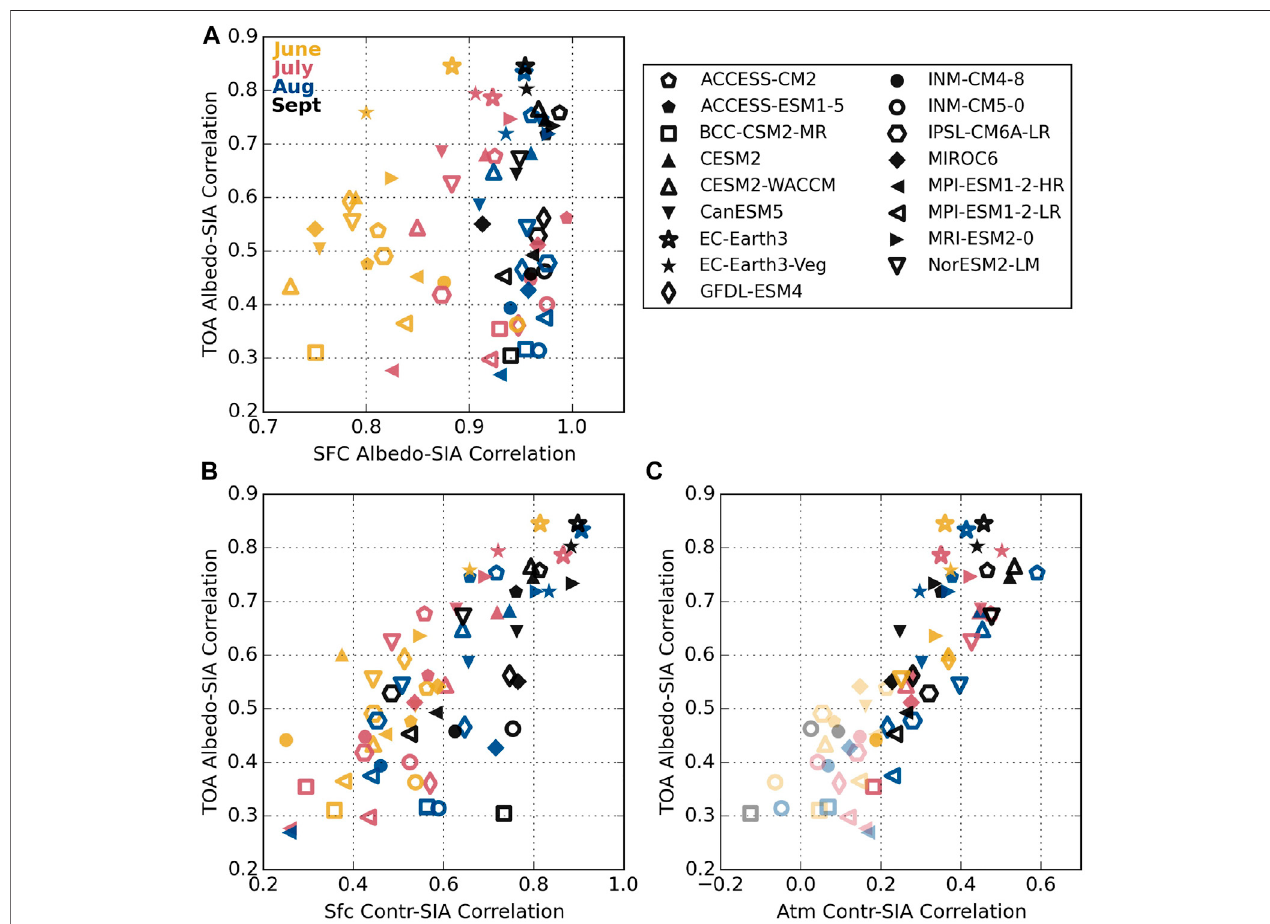
FIGURE 4 | Correlations between albedos and SIA as they relate to each other during summer months. Correlation coef fi cients are calculated over the historical period,1900 – 2014,usingdetrendedanomalies.Correlationcoef fi cientsthatareconsideredstatisticallysigni fi cantusinga t -testwith95%signi fi cancelevelandeffective sample sizes that take into autocorrelation have opaque markers; statistically insigni fi cant correlations are semi-transparent.